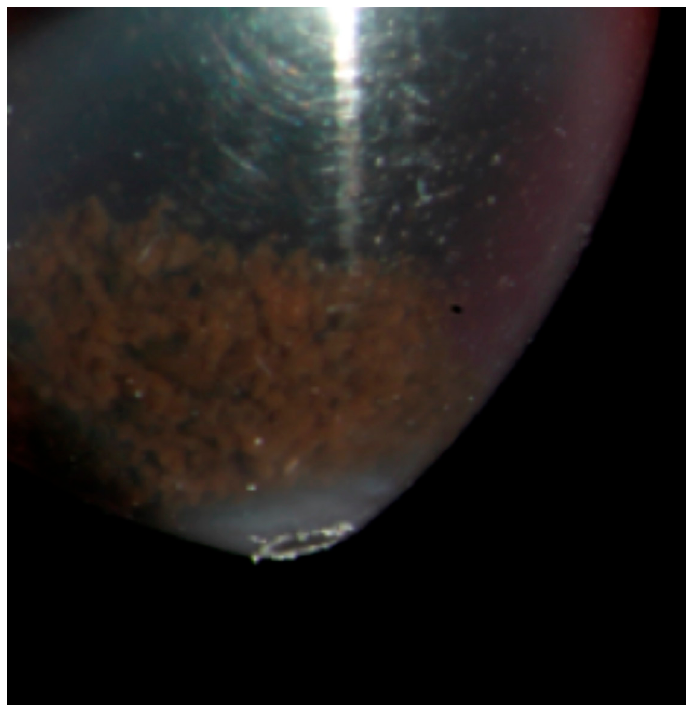
Figure 9. Fine needle aspiration biopsy sample in a medium sized posterior uveal melanoma: a large number of cells is obtained and collected in a vial with the culture medium Roswell Park Memorial Institute (RPMI) 1640 (Euroclone Life Science, Pero-MI, Italy) before the genetic analysis. The obtained material is visible in the vial as a brown deposit at the bottom of the